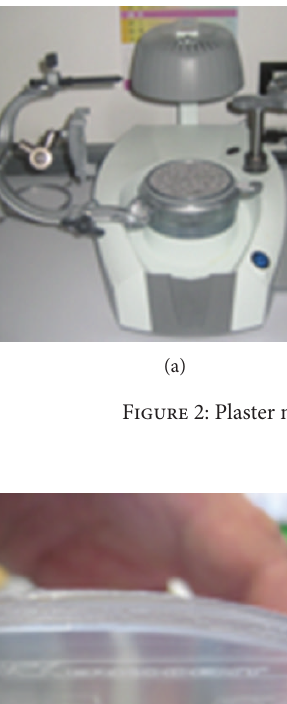
he stopped biting himself, also without the mouthguard